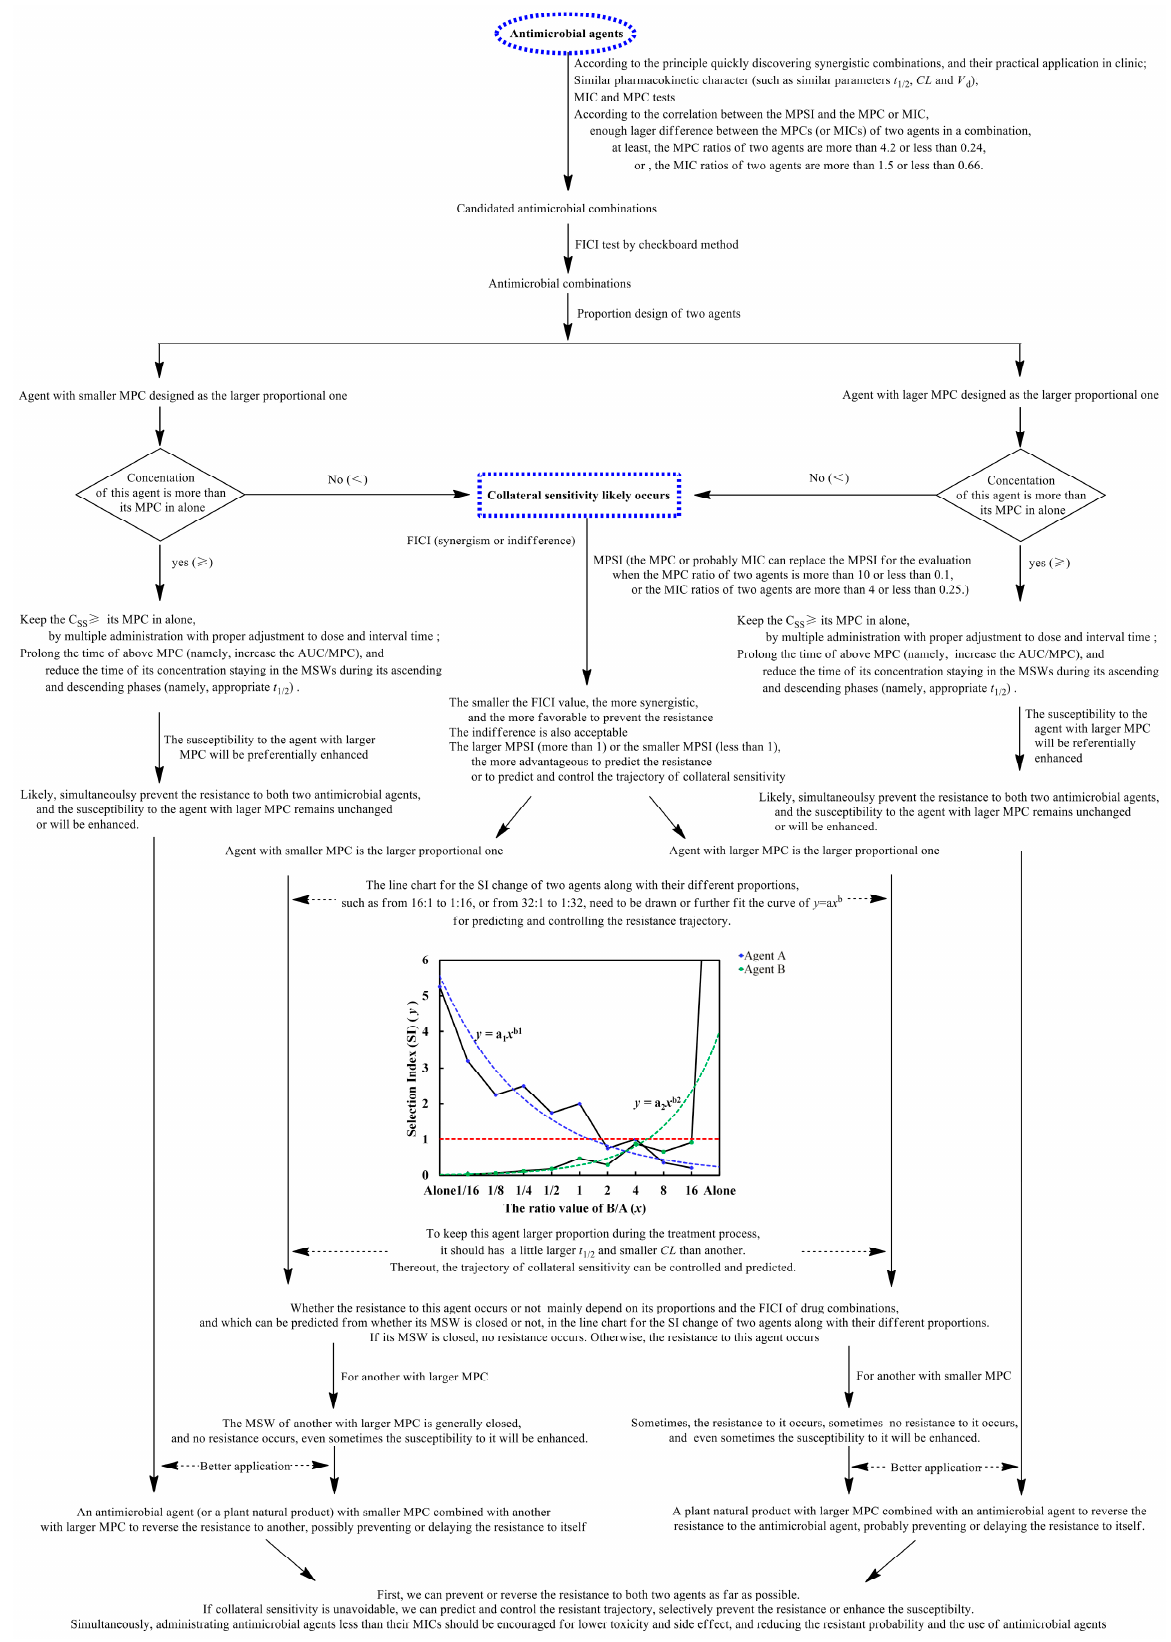
Figure 4. The preliminary scheme for drug combinations to prevent antimicrobial resistance.